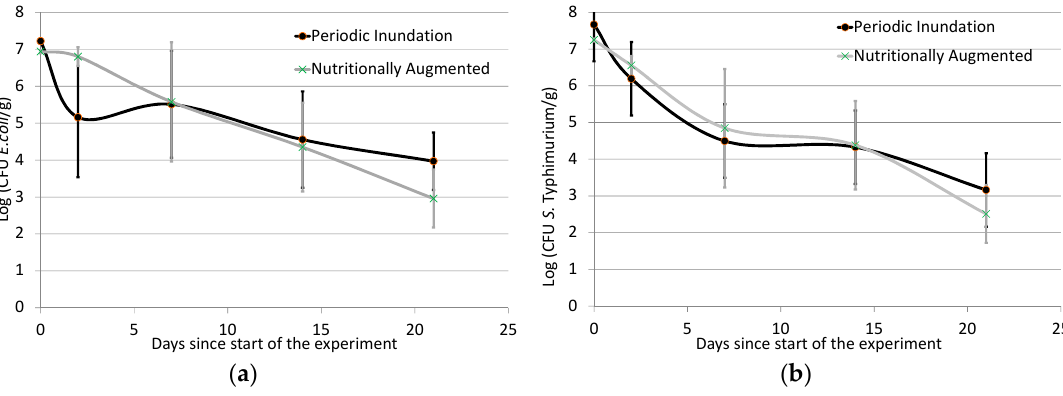
Figure A1. Influence of augmented nutrition on survival of ( a ) E. coli K1 and ( b ) S. Typhimurium NVSL 6993 (error bars represent standard deviations around the mean values for each of the configurations).